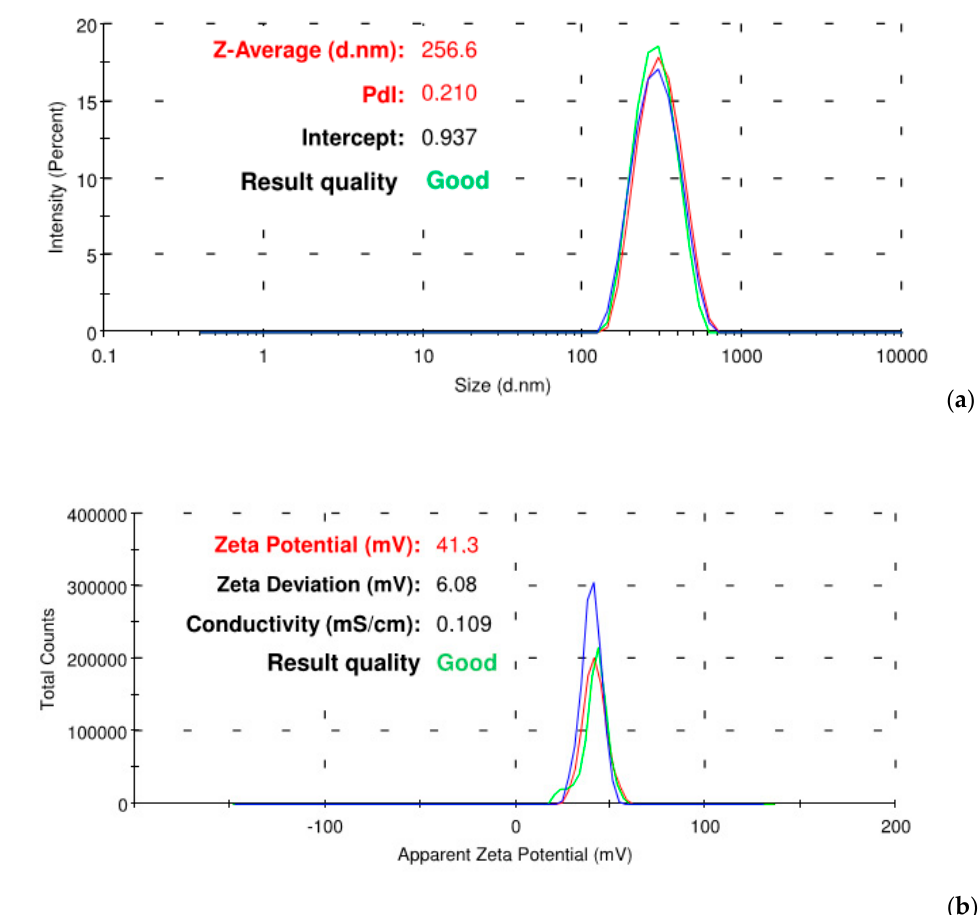
Figure 7. ( a ) Representative size distribution of 4-HPR-P5 NPs and ( b ) representative zeta potential obtained by dissolving 2 mg/mL of nanoparticles in water at 25 °C.